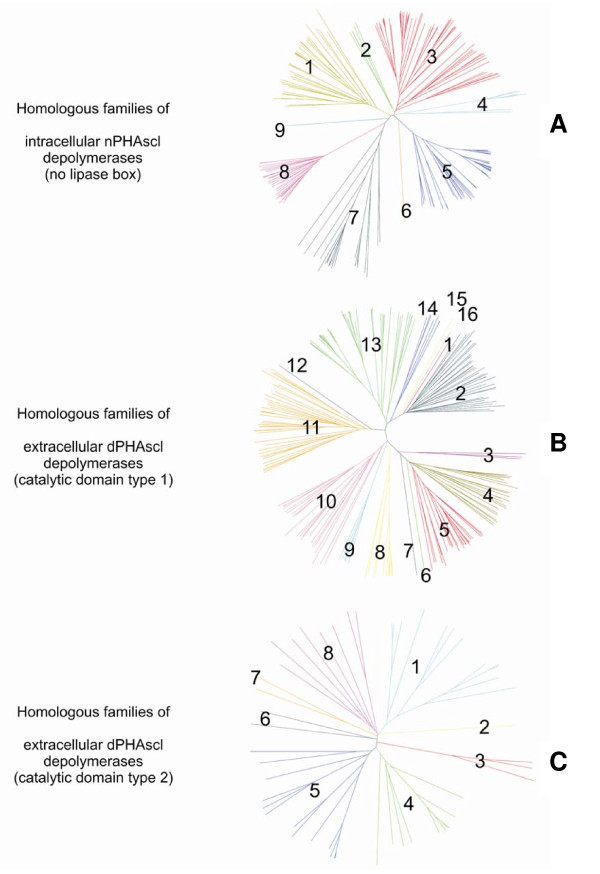
Assignment of homologous families. Homologous families of intracellular nPHASCL depolymerases (no lipase box) [A], extracellular dPHASCL depolymerases (catalytic domain type 1) [B], and extracellular dPHASCL depolymerases (catalytic domain type 2) [C]. The homologous family number is indicated.